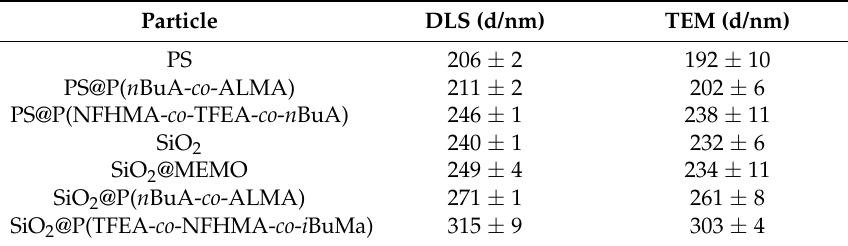
Figure 2. ( a ) DLS measurements of SiO 2 core particles, MEMO-functionalized SiO 2 particles, SiO 2 core/P( n BuA- co -AMLA)-interlayer particles, and SiO 2 core/P( n BuA- co -ALMA)interlayer/P(TFEA- co -NFHMA- co - i BuMA)-shell particles; ( b ) TEM image of SiO 2 -core particles; ( c ) TEM image of MEMO-functionalized SiO 2 particles; ( d ) TEM image of SiO 2 core/interlayer particles; ( e ) TEM image of SiO 2 core interlayer shell particles. Table 1. Average hydrodynamic diameter of particles measured by means of DLS and average diameters of the dried particle, as determined by TEM. In the case of TEM analysis, 50 particles were measured with respect to their size.